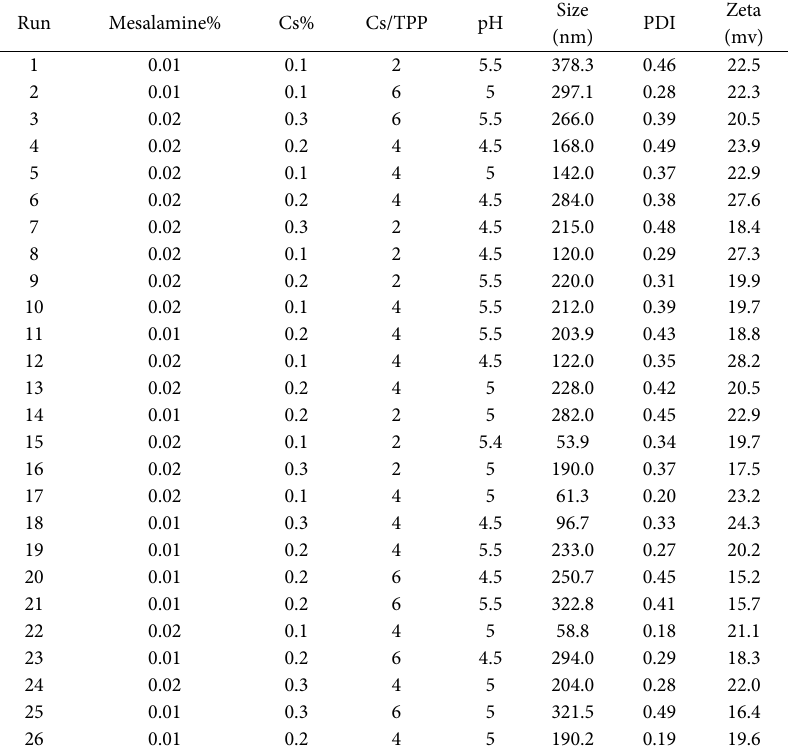
Table 2. Box-Behnken experimental design